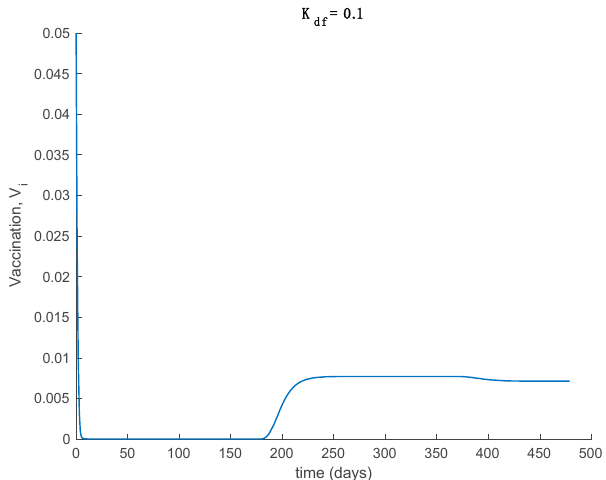
Figure 13. Vaccination action for Case 1.7 conditions.